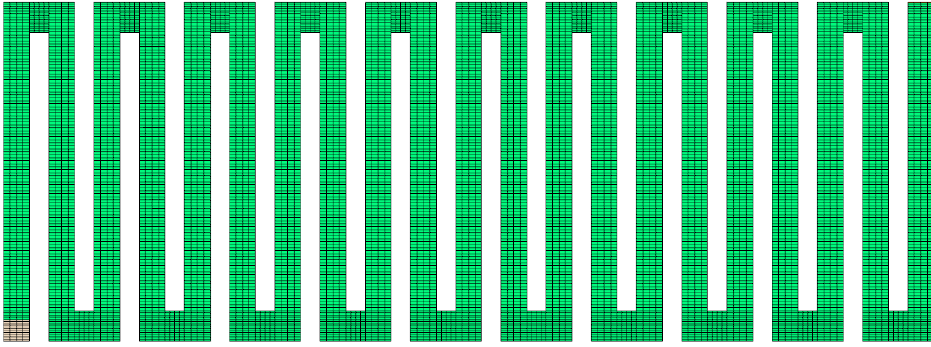
( b ) Figure 5. ( a ) Mesh distribution on the interface between bipolar plates and GDLs and ( b ) between GDLs and membrane. 5. Numerical Results Numerical simulations are carried out for the voltage range from 0.2 to 0.7 V, with 0.1 V steps. In this section the numerical results are reported in detail for the extreme cases, i.e., 0.7 and 0.2 V. Results will focus on species distribution, reaction rate, and thermal gradients, as well as on water formation on the cathode side. Finally, a section will be dedicated to an improved formulation for the exchange current density at cathode, representing a fundamental modelling aspect. Three-dimensional fields are analyzed for each voltage, which is applied as a boundary condition at the cathode current collector. As shown in Figure 6, hydrogen is consumed from the inlet to the outlet on the side of the anode, while the same is verified for oxygen on the cathode side. The images refer to the 0.7 V configuration and the fields of the molar fractions are extracted at the ACL and to the CCL, respectively, then to the contact interface between the layers of porous diffusion and the polymer membrane. As is visible, the porous GDL allows reactants to distribute over the entire active surface of the catalyst layers for electrochemical reactions, hence its accurate representation is of utmost relevance to reproduce the species diffusivity in this diffusion-dominated region.